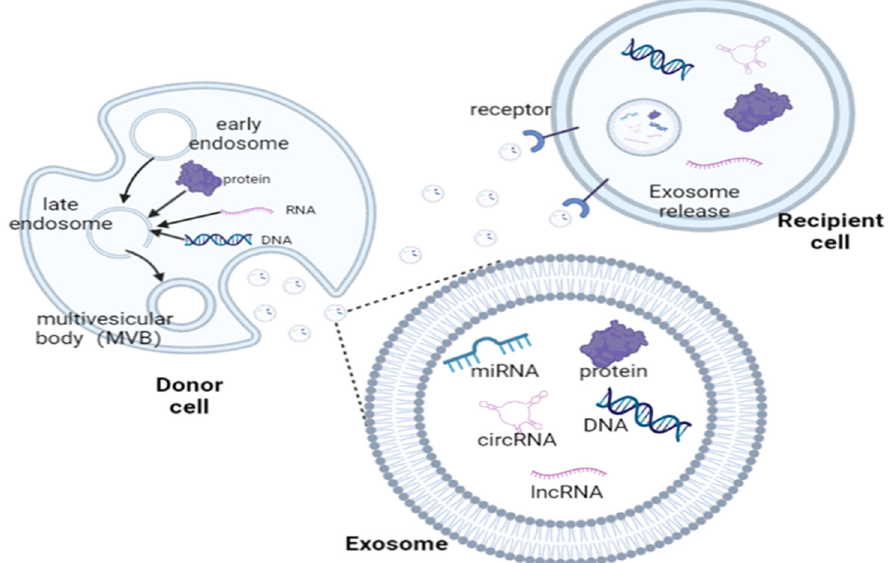
Figure 1. Exosome formation and their role in intercellular communication. Exosomes are formed from endosomes and serve as a link between cells, transporting various biologically active molecules to recipient cells.